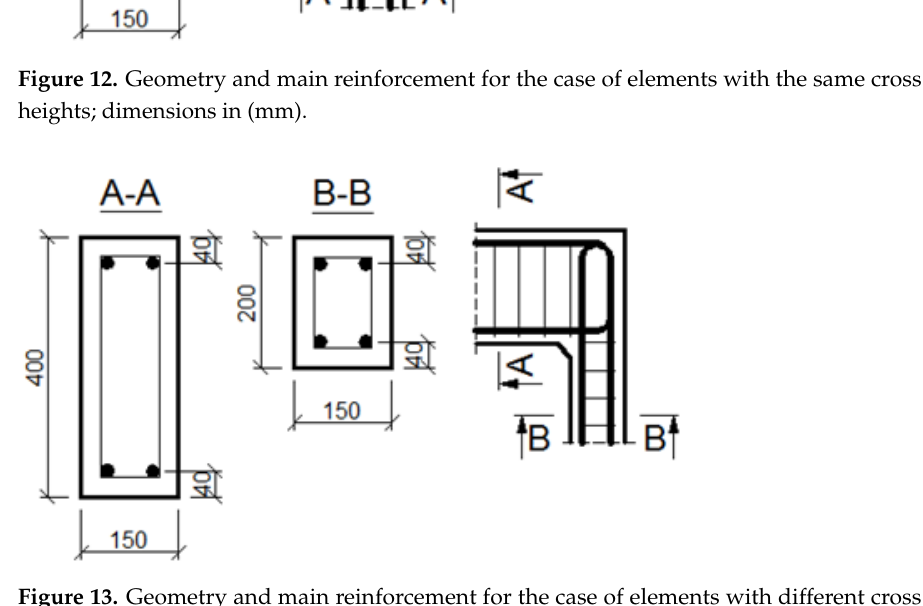
Figure 13. Geometry and main reinforcement for the case of elements with different cross section heights; dimension in (mm).